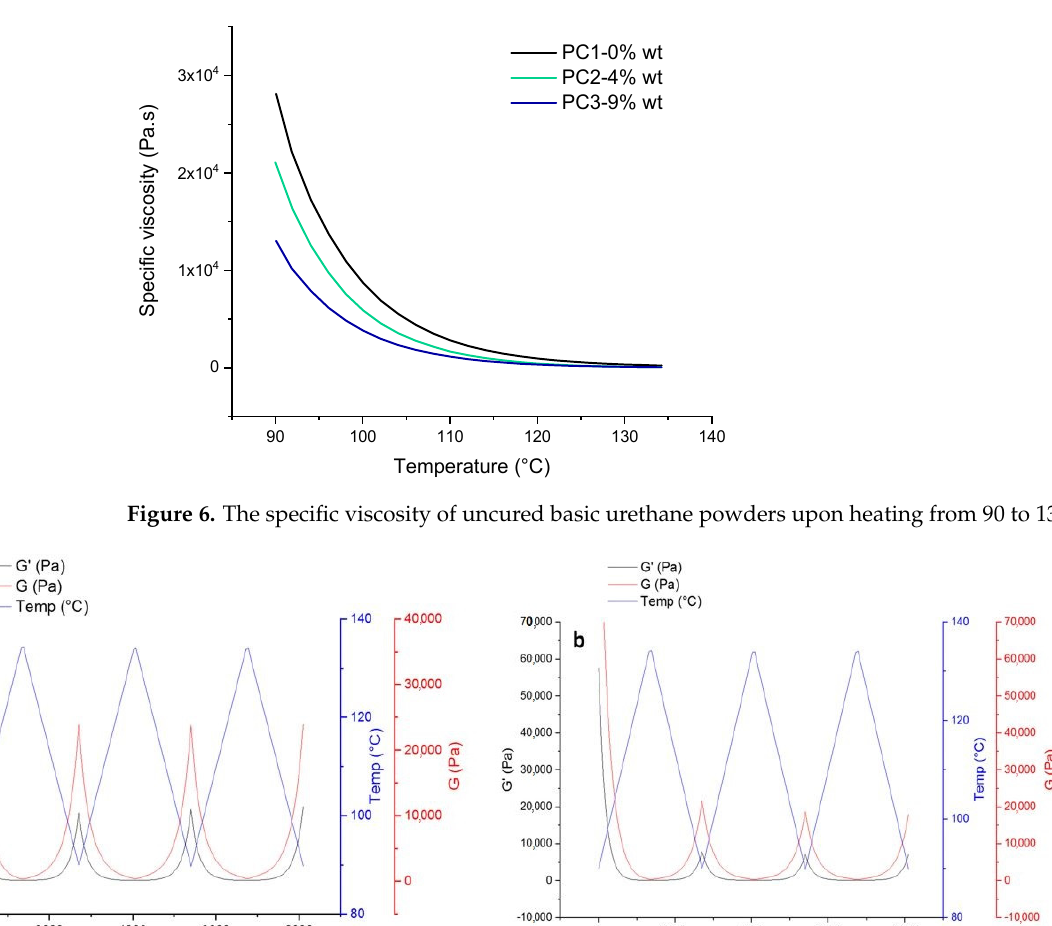
Figure 7. The thermo-reversible behavior of uncured powder samples containing HA based on storage and lost modulus. ( a ) Contains 4% wt. HA, and ( b ) 9% wt. HA.